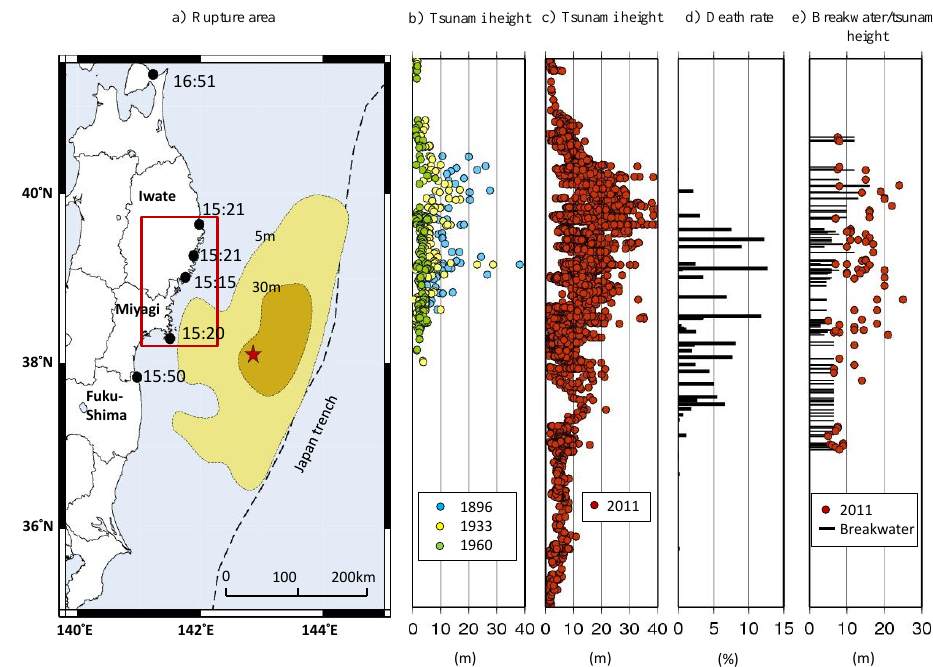
Fig. 1. (a) The rupture area of the 11 March 2011 Great East Japan Earthquake, including 5m and 30m fault slip contours (Lee et al., 2011). The epicenter of the main shock (star) and the area in which people were interviewed (red rectangle) are shown. The arrival times of the large tsunami waves at tide gauge stations (black circles) are shown in local time (UT+9h). These waves arrived at inner-bay towns 3–5min later. (b) Inundation heights (m) along the Tohoku coast for the 16 June 1896 M t = 8 . 2, 3 March 1933 M w = 8 . 3, and 23 May 1960 M w = 9 . 5 (Chile) tsunamis (Usami, 2003). (c) The wave heights of the tsunami following the 11 March 2011 M w = 9 . 0 earthquake (2011 Tohoku Earthquake Tsunami Joint Survey Group, No. 4 in Table 1). (d) The estimated death rate (%) in the inundated areas of each municipality, following the 2011 Great East Japan Earthquake. The number of deaths and missing persons in each municipality and the inundation areas are provided by the Statistics Bureau and the Director General for Policy Planning of Japan (DGPPJ) (No. 4 in Table 1). (e) The heights of breakwaters and tsunami waves at the corresponding sites (the Central Disaster Prevention Council, Cabinet Office, No. 11 in Table 1). Only in the northernmost areas were the breakwaters higher than the incoming tsunami waves, but the tsunami still flooded through gaps in the breakwaters (Iwate prefecture